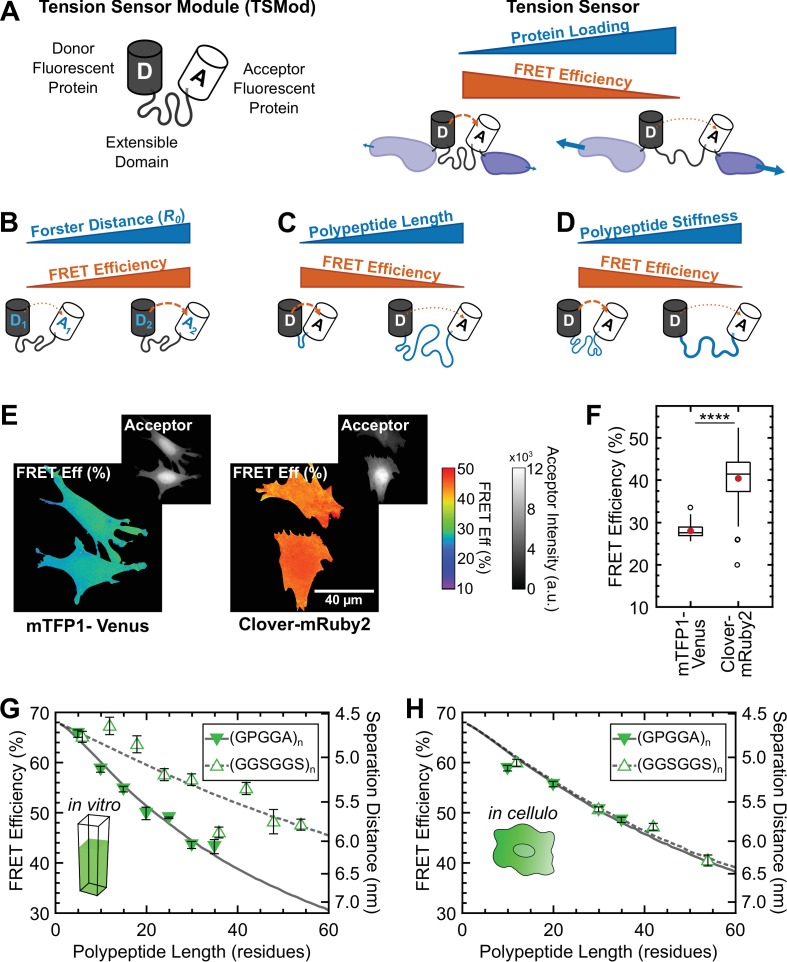
Design and characterization of tunable FRET-based molecular tension sensors.(A) Schematic depiction of a generic TSMod and inverse relationship between FRET and force for molecular tension sensors under tensile loading. (B-D) TSMod function depends on the Förster radius of the chosen FRET pair (B) as well as the length (C) and stiffness (D) of the extensible polypeptide domain. (E) Representative images of soluble mTFP1-Venus and Clover-mRuby2 TSMods expressed in Vin-/- MEFs. (F) Quantification of unloaded FRET efficiency for mTFP1-Venus and Clover-mRuby2 TSMods; (n = 53 and 92 cells, respectively); red filled circle denotes sample mean; **** p < 0.0001, Student’s t-test, two-tailed, assuming unequal variances. (G) Quantification of FRET-polypeptide length relationship for minimal Clover-mRuby2 TSMods in vitro; each point represents data from at least 5 independent experiments; lines represent model fits where LP is the only unconstrained parameter. (H) Quantification of FRET-polypeptide length relationship for minimal Clover-mRuby2 based TSMods in cellulo; each point represents at least n = 48 cells from three independent experiments; lines represent model fits where LP is the only unconstrained parameter. All error bars, s.e.m.10.7554/eLife.33927.010Figure 1—source data 1.Measurements and models of the mechanical behavior of TSMods in vitro and in cellulo.